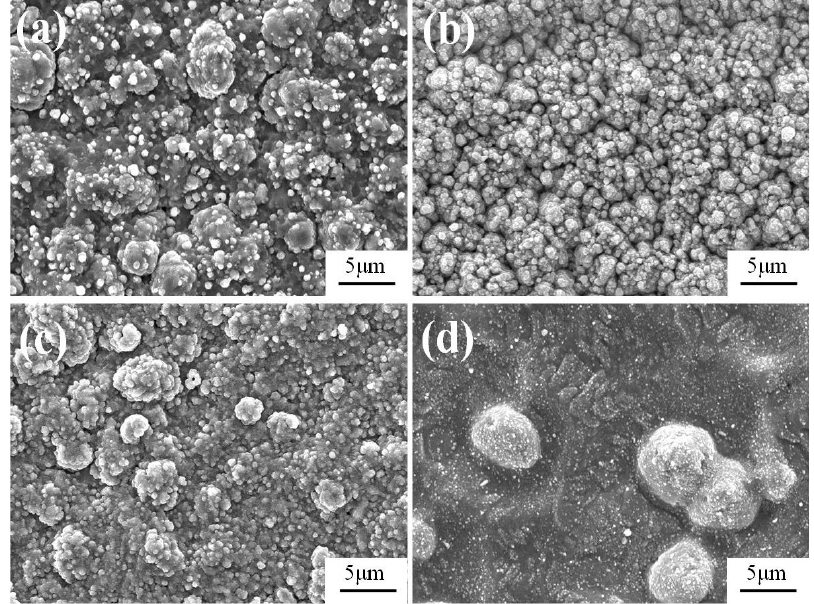
Figure 4. The surface morphology of Fe-Al-Cr alloyed layers under different gas pressures: ( a ) 25 Pa; ( b ) 35 Pa; ( c ) 45 Pa; ( d ) 55 Pa.